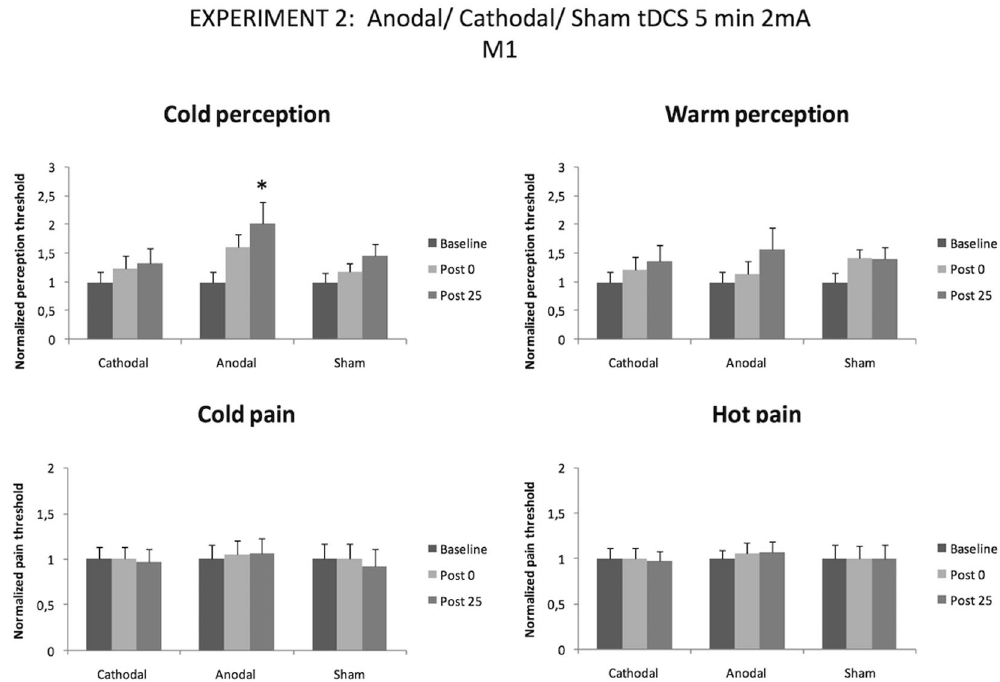
Figure 5. Temperature pain thresholds for hot and cold perception (anodal, cathodal and sham stimulation, tDCS 5 min 1 and 2 mA over motor cortex). Error bars are standard deviations. * p <